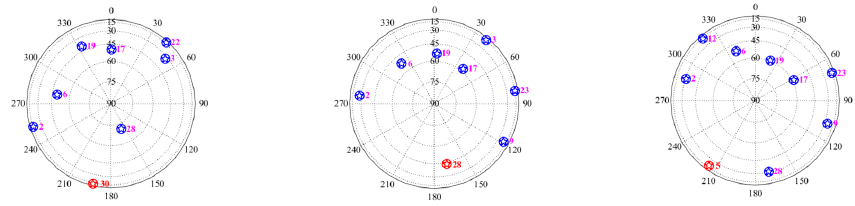
Figure 6. ( left ) Sky plot at 14.75 h on 25 March 2017; ( middle ) Sky plot at 15.5 h on 25 March 2017; ( right ) Sky plot at 15.9 h on 25 March 2017. Table 1. Maximum ionospheric anomaly gradients for different satellites.